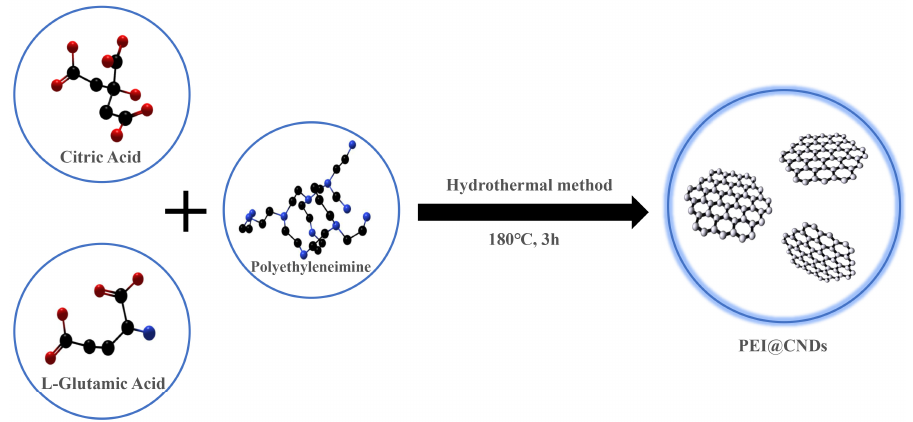
Figure 1. Schematic diagram of the fabrication of PEI@CNDs.